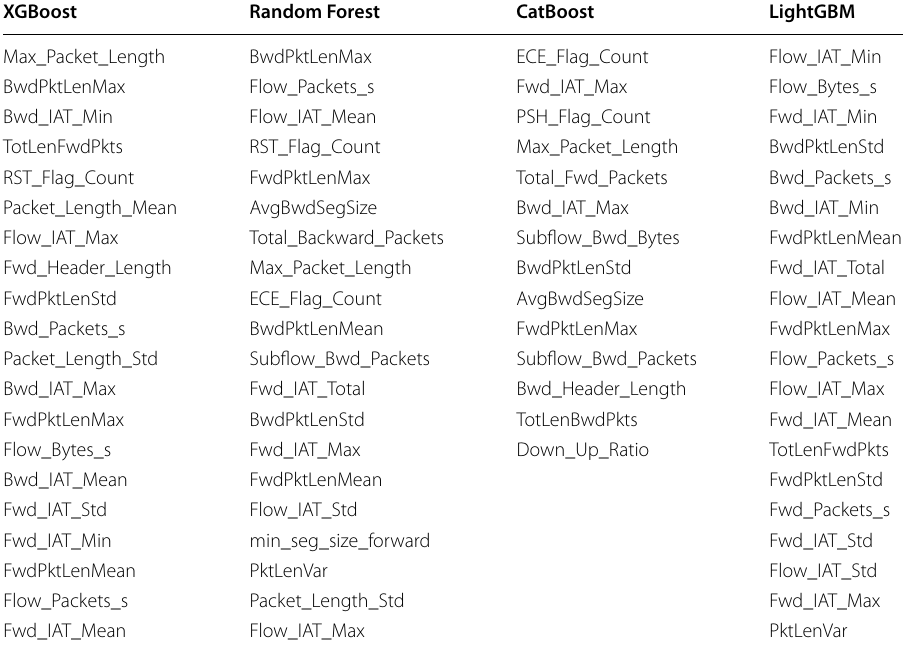
Table 17 Top 20 features for SQL Injection web attacks ranked by Supervised-based Feature Importance